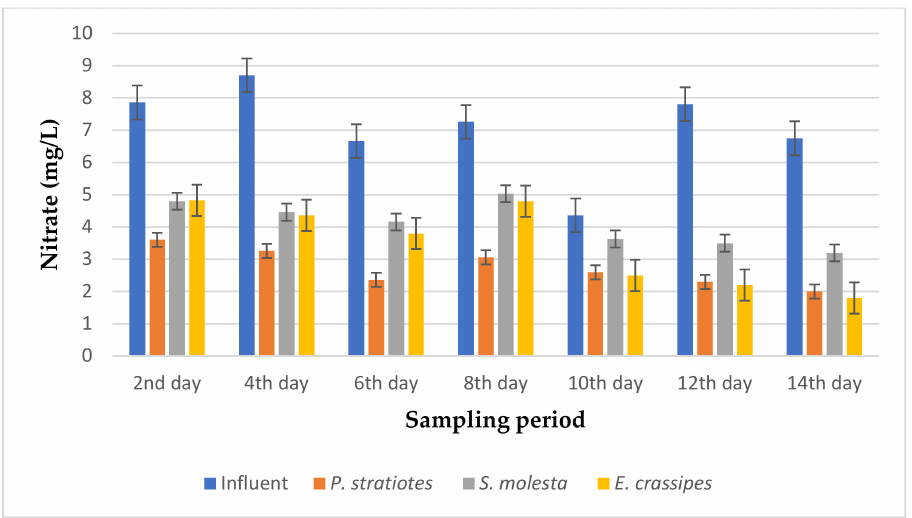
Figure 12. Bar plot of the average nitrate vs. the sampling period with a 6 h retention time.